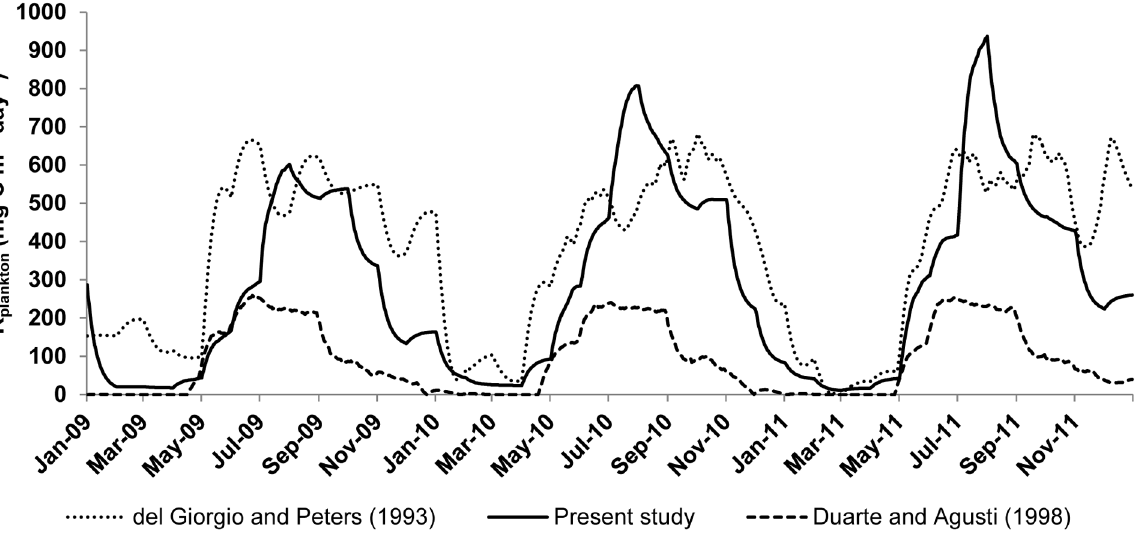
Figure 6. Comparison of plankton respiration (mg C m 2 3 day 2 1 ) in Vo˜rtsja¨rv calculated with an ecosystem approach (this study), chl- a -based del Giorgio and Peters [40] and GPP-based Duarte and Agusti [56] equations. In this study R plankton = R phytoplankton + R bacterioplankton + R protozooplankton + R metazooplankton .